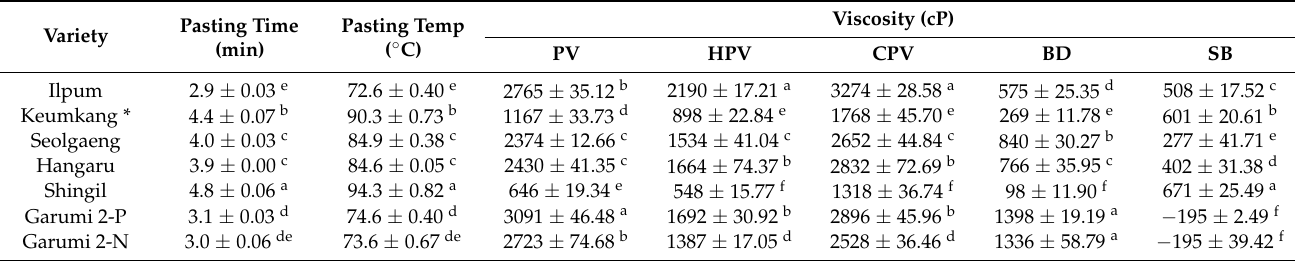
Table 2. Pasting properties of flours obtained from different varieties of rice.